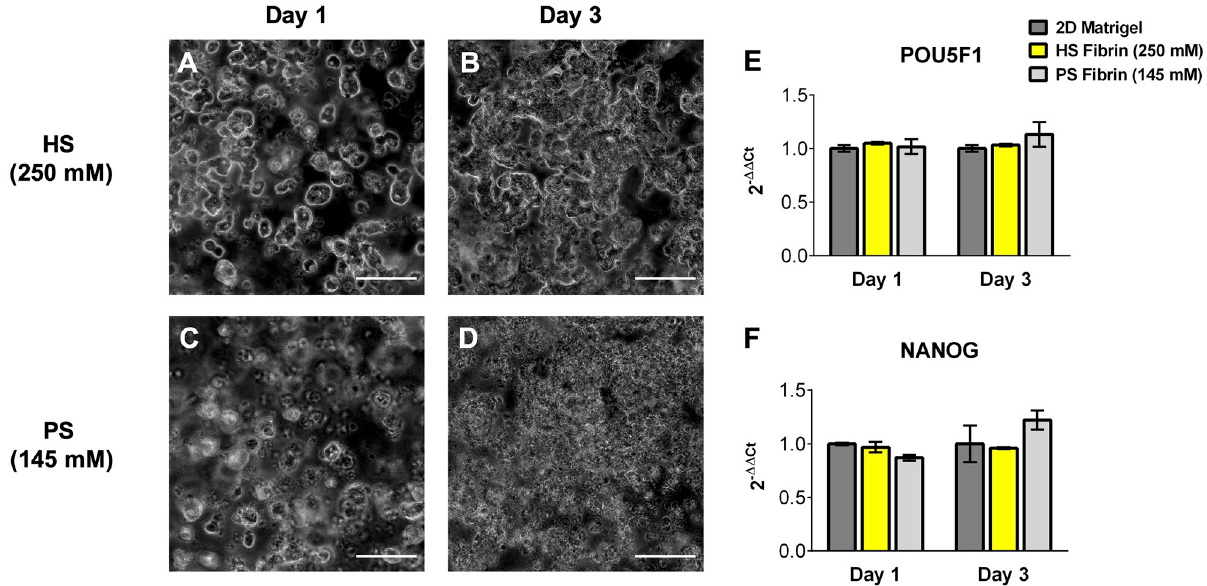
Fig 6. PS and HS gels support iPSC expansion and pluripotency. Both gel types maintain expression of pluripotency genes POU5F1 (E) and NANOG (F) compared to standard 2D Matrigel 1 culture. HS gels appear to drive formation of spheroid-like iPSC colonies (A,B) while PS gels appear to maintain singularized iPSC (C,D). Scale bars